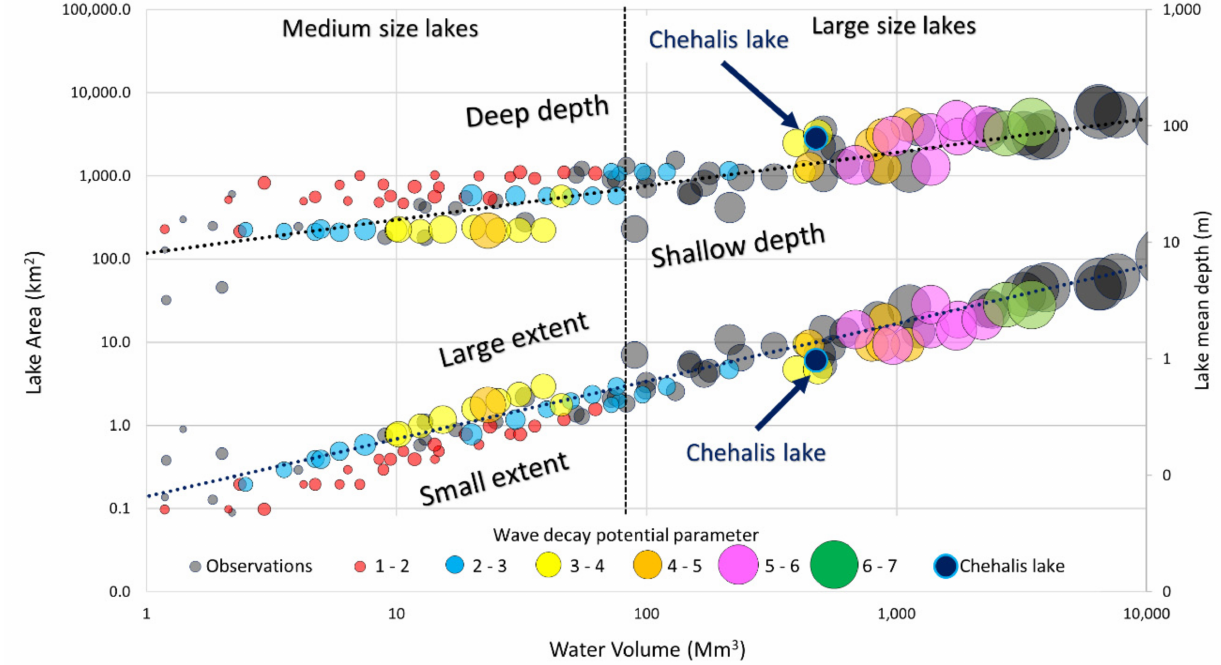
Figure 11. Comparison of modeling results (circle size and color based on WDPP ; black circles are from the alpine lakes classification chart, see Section